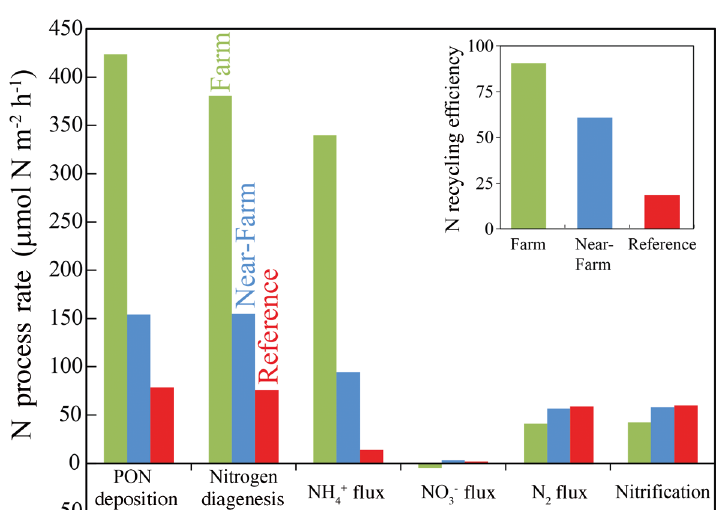
Fig. 10. Comparison of annual means of major nitrogen processes within the sediment at the farm, near-farm, and reference sites. The inset shows